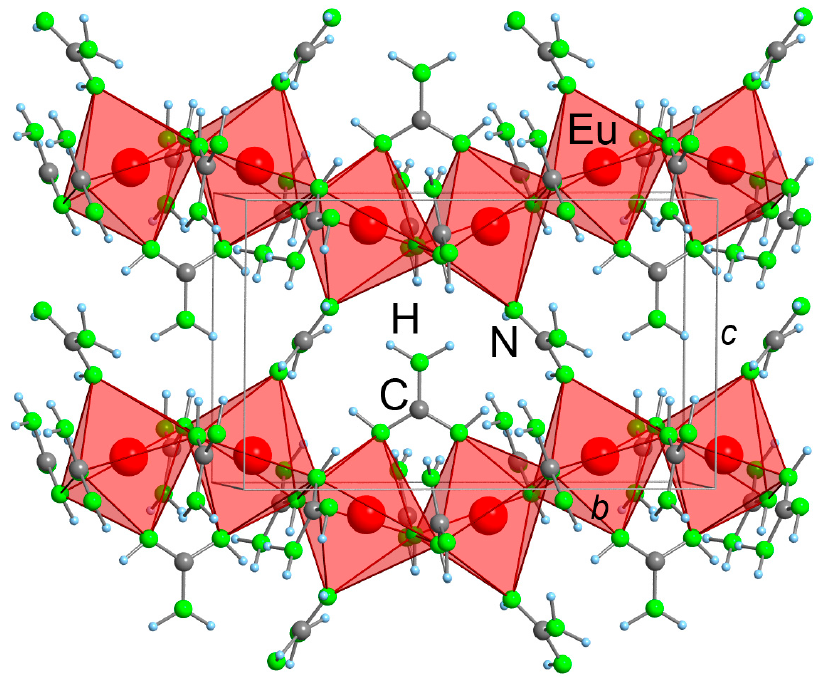
Figure 5. Crystal structure of α -Eu(CN 3 H 4 ) 2 shown along the a -axis as optimized by